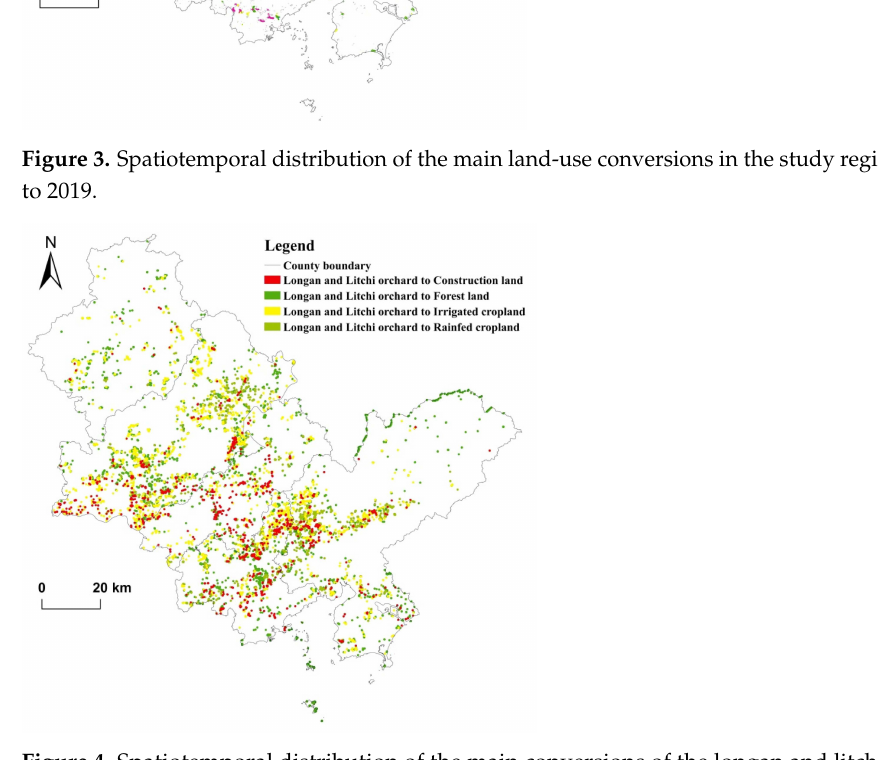
Figure 4. Spatiotemporal distribution of the main conversions of the longan and litchi orchards in the study region from 2015 to